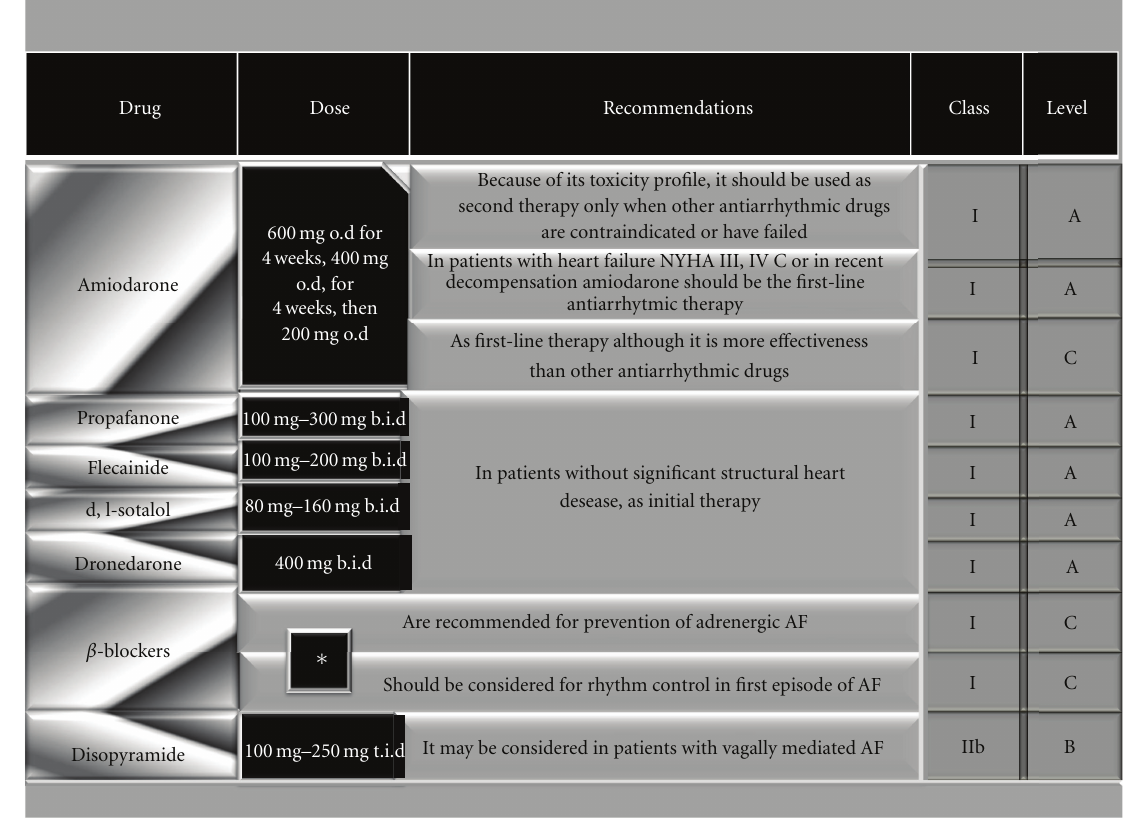
Figure 2: ACC/AHA/ESC algorithm for antiarrhythmic maintenance drug therapy. ∗ The dosage must be